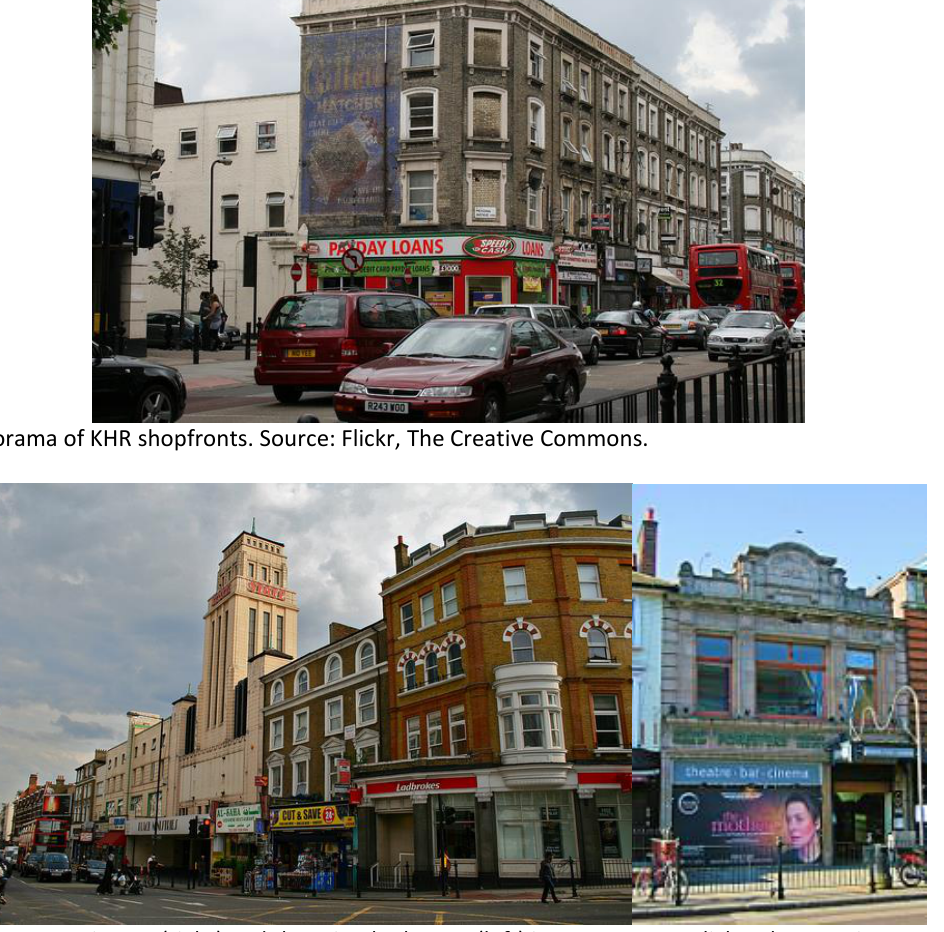
Figure 5. The Gaumont Cinema (right) and the Tricycle theatre (left) in KHR. Source: Flickr, The Creative Commons.